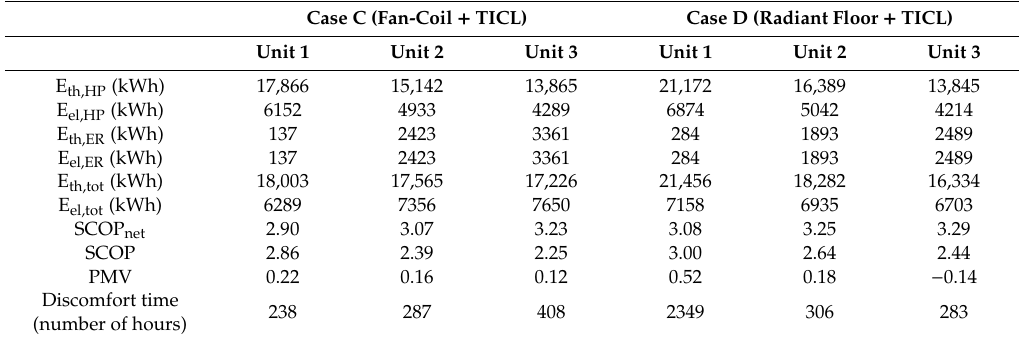
Table 4. Seasonal energy consumptions and key performance indicators of the simulated systems with the adoption of TICL